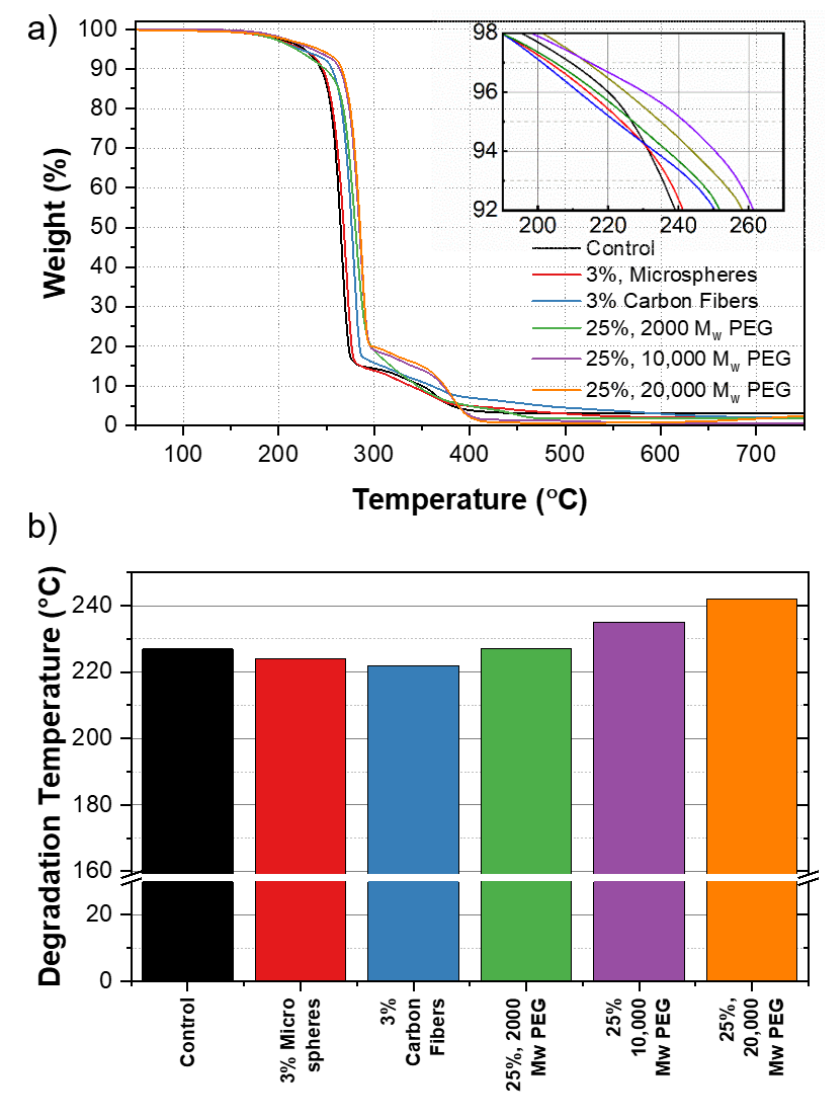
Figure 8. ( a ) TGA curves of PHB composites. The inset shows the degradation temperature, T d across samples. ( b ) Comparison of T d for PHB control against PHB composite across samples. ( b ) Comparison of T d for PHB control against PHB composite samples.